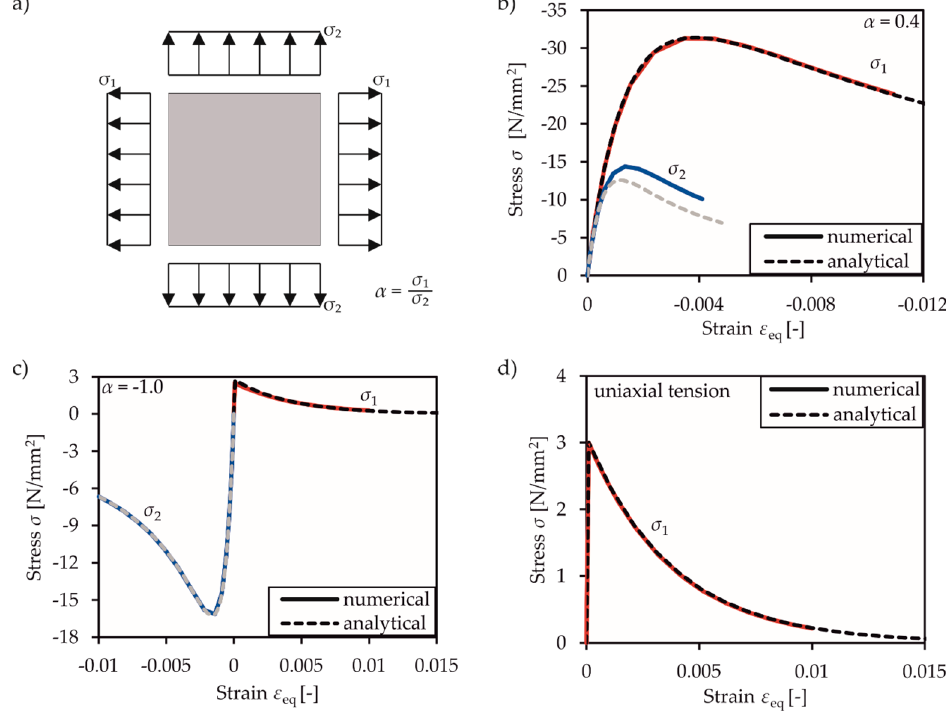
Figure 6. Illustration of ( a ) principal stress state, and of numerical verification results compared to analytic solution for ( b ) compression-compression, ( c ) tension-compression, and ( d ) uniaxial tension.